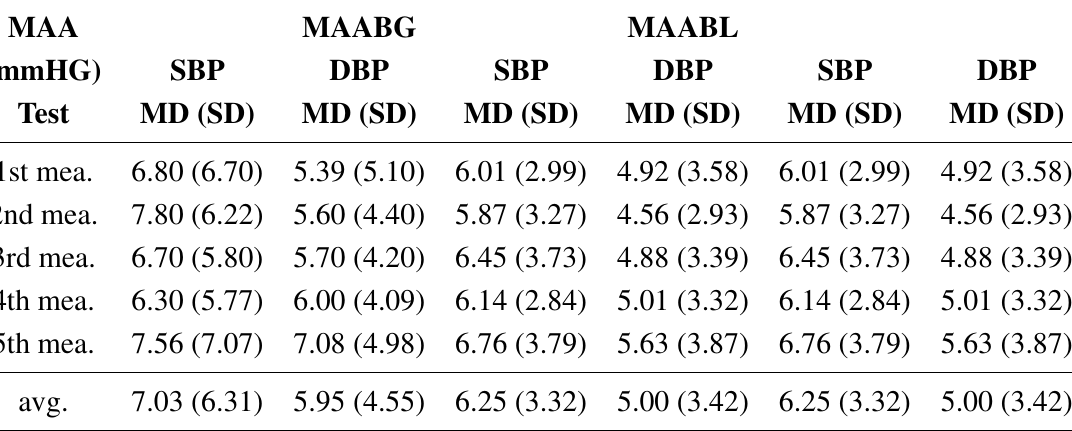
Table 5. Summary of the MD and SD obtained using the MAA and the proposed methods (MAABG and MAABL) relative to the reference auscultatory method.